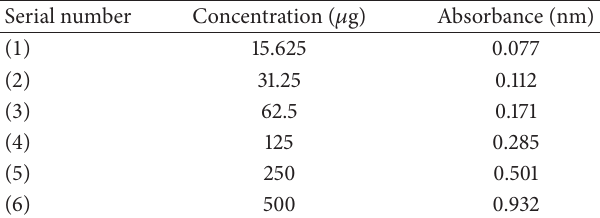
Table 1: Standard calibration data for volatile oil of Khardal